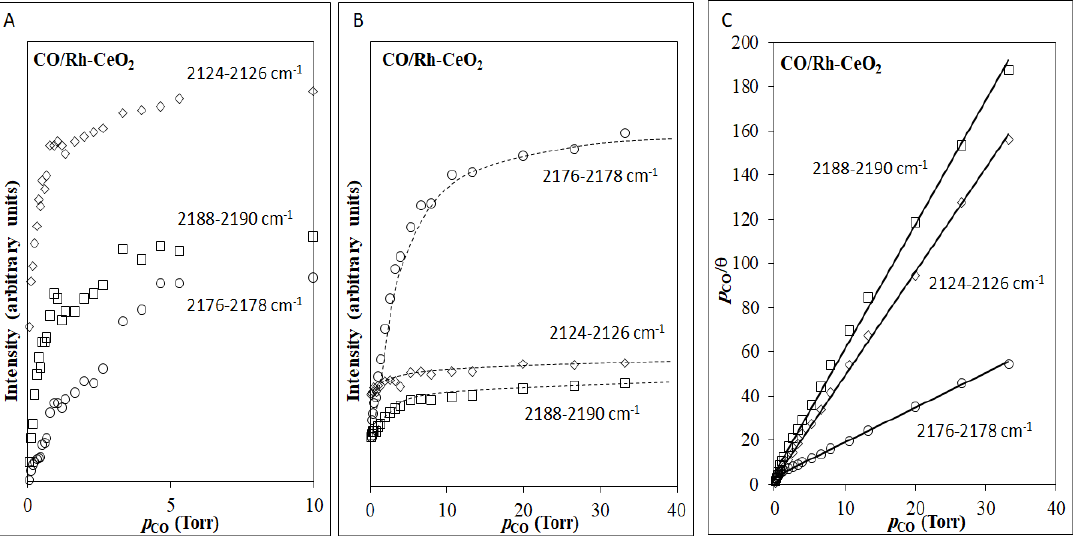
Figure 6. ( A ) A plot of dependence of the adsorbed intensity of the CO bands ( (cid:3) ) 2190 cm − 1